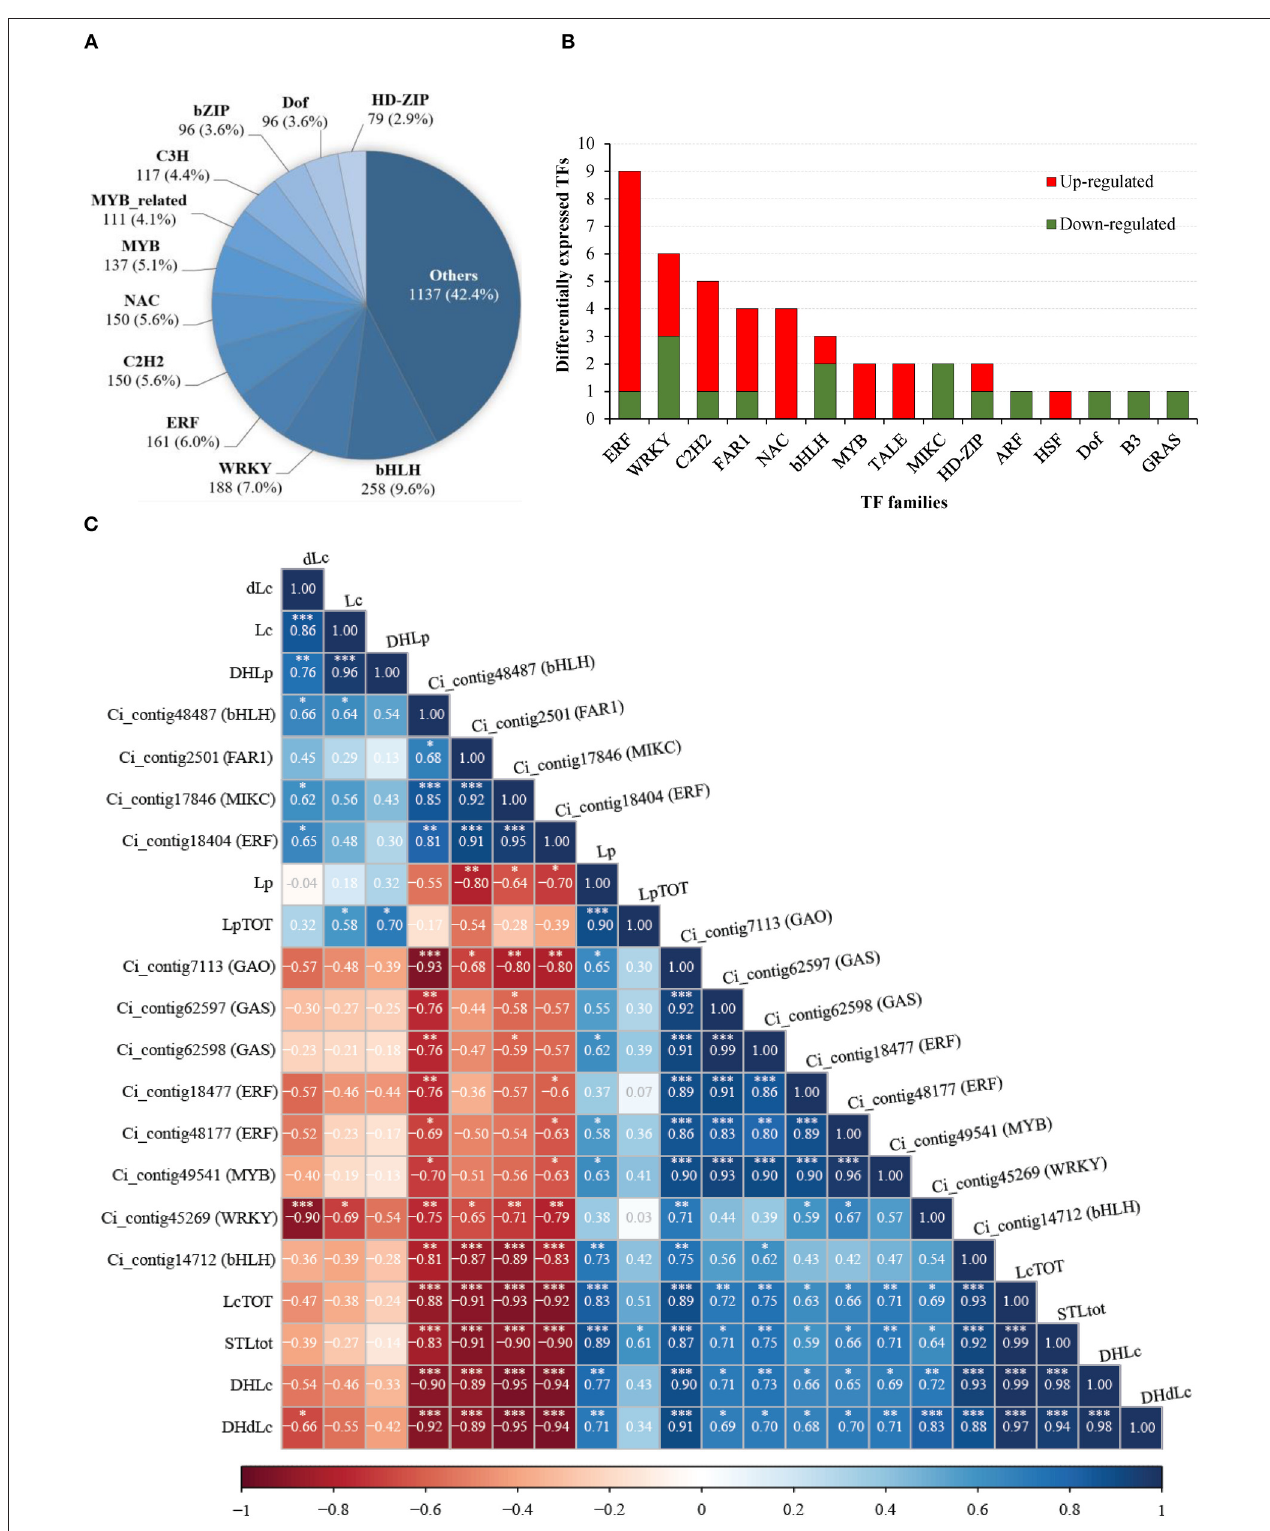
FIGURE 7 | Analysis of transcription factors (TFs) in C. intybus ‘Catalogna’ landraces. (A) Categorization of predicted TFs into families. The numbers below each TF family (bold) indicate the number of unigenes within the group. Family relative abundance (percentage) with respect to the total predicted TFs is in parenthesis. (B) Analysis of differentially expressed (FDR ≤ 0.05; |log2FC| ≥ 1) TFs in Mol vs. Gal independently by the cultivation area. Red and green bars refer to